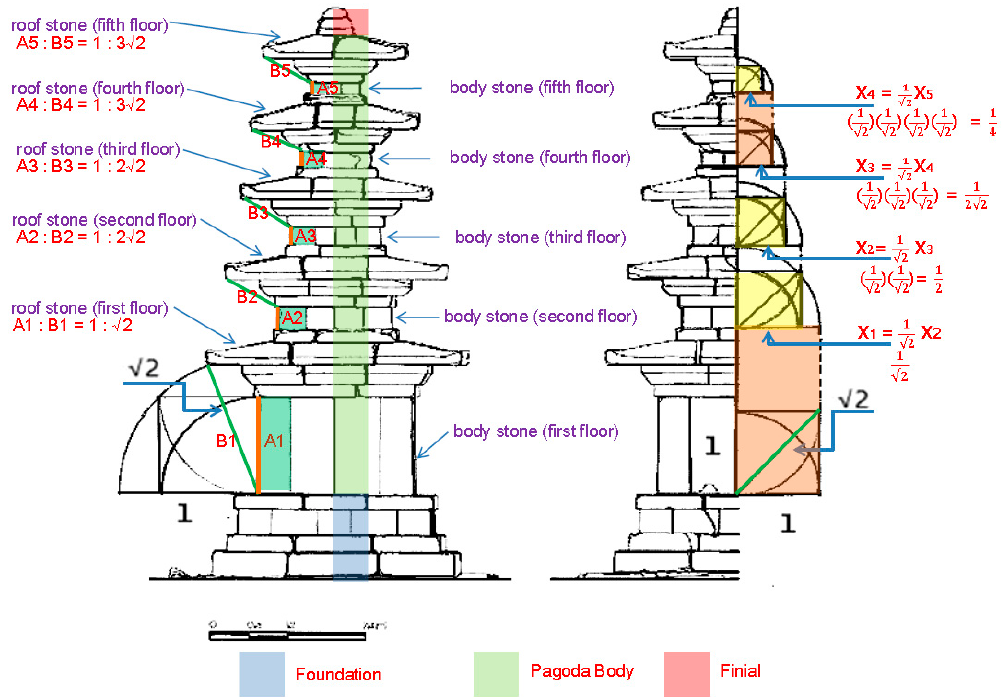
Figure 6. Proportional analysis of the five-story pagoda at Ch ŏ ngnimsa Temple.